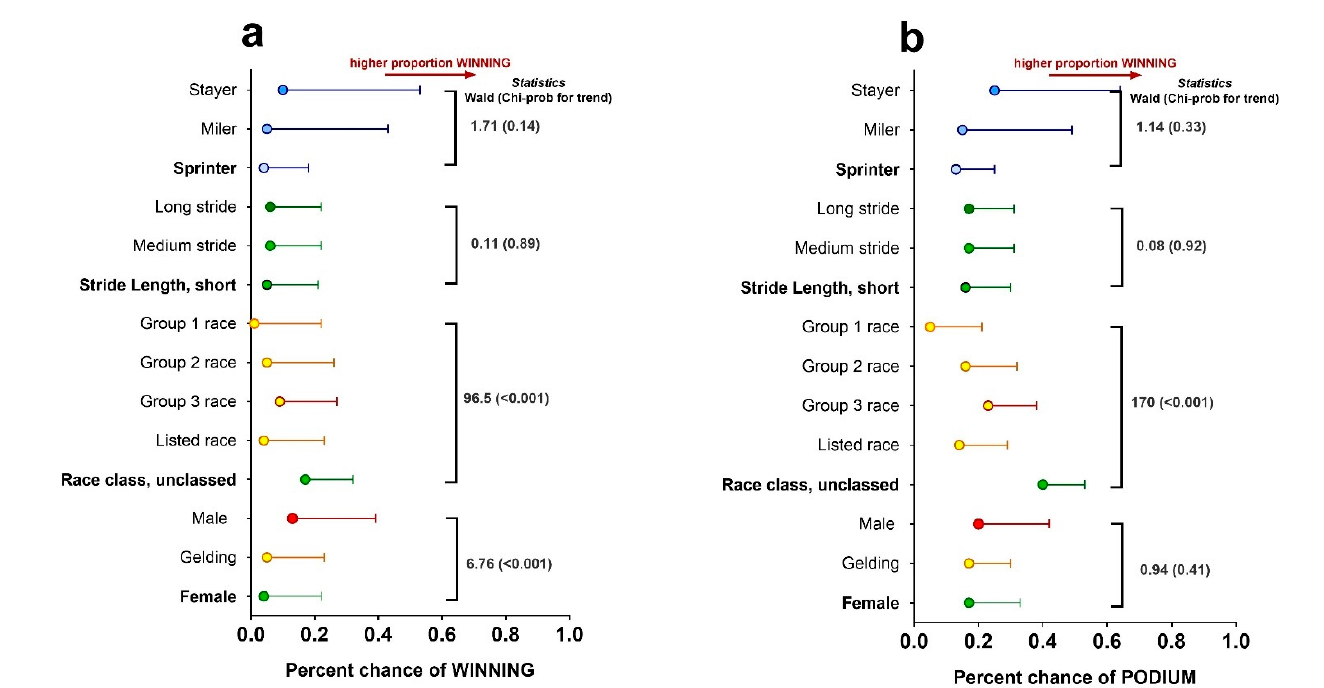
Figure 3. Predicting race wins or podium places on training data. Predicting race wins or podium places on training data. Data are predicted mean ± SEM for ( a ) winning a race (left graph) or ( b ) achieving a top three placing (right graph). Predicted means were obtained by integrating known race outcome data from Racing.com (Victoria, Australia; n = 421 different racehorses, n = 3269 different races) with training data (only gallop on turf) for the same horses before and during two race seasons ( n = 1799 different training sessions). Data were analysed with race outcome (e.g., win or top three) as the variable of interest fitting sex of horse, race class, stride length and age as fixed effects in the model. Since the same horse completed multiple training sessions and multiple races then the individual horse was fitted as a random effect using Generalised Linear Mixed Models (GLMM). Statistics for main effects are indicated on the right on the graph with associated Wald statistic and χ 2 probability. Statistical significance was accepted at p < 0.05. Table 4. Heritability ( h 2 ) of locomotory and peak heart rate during race-speed training efforts categorised by type of